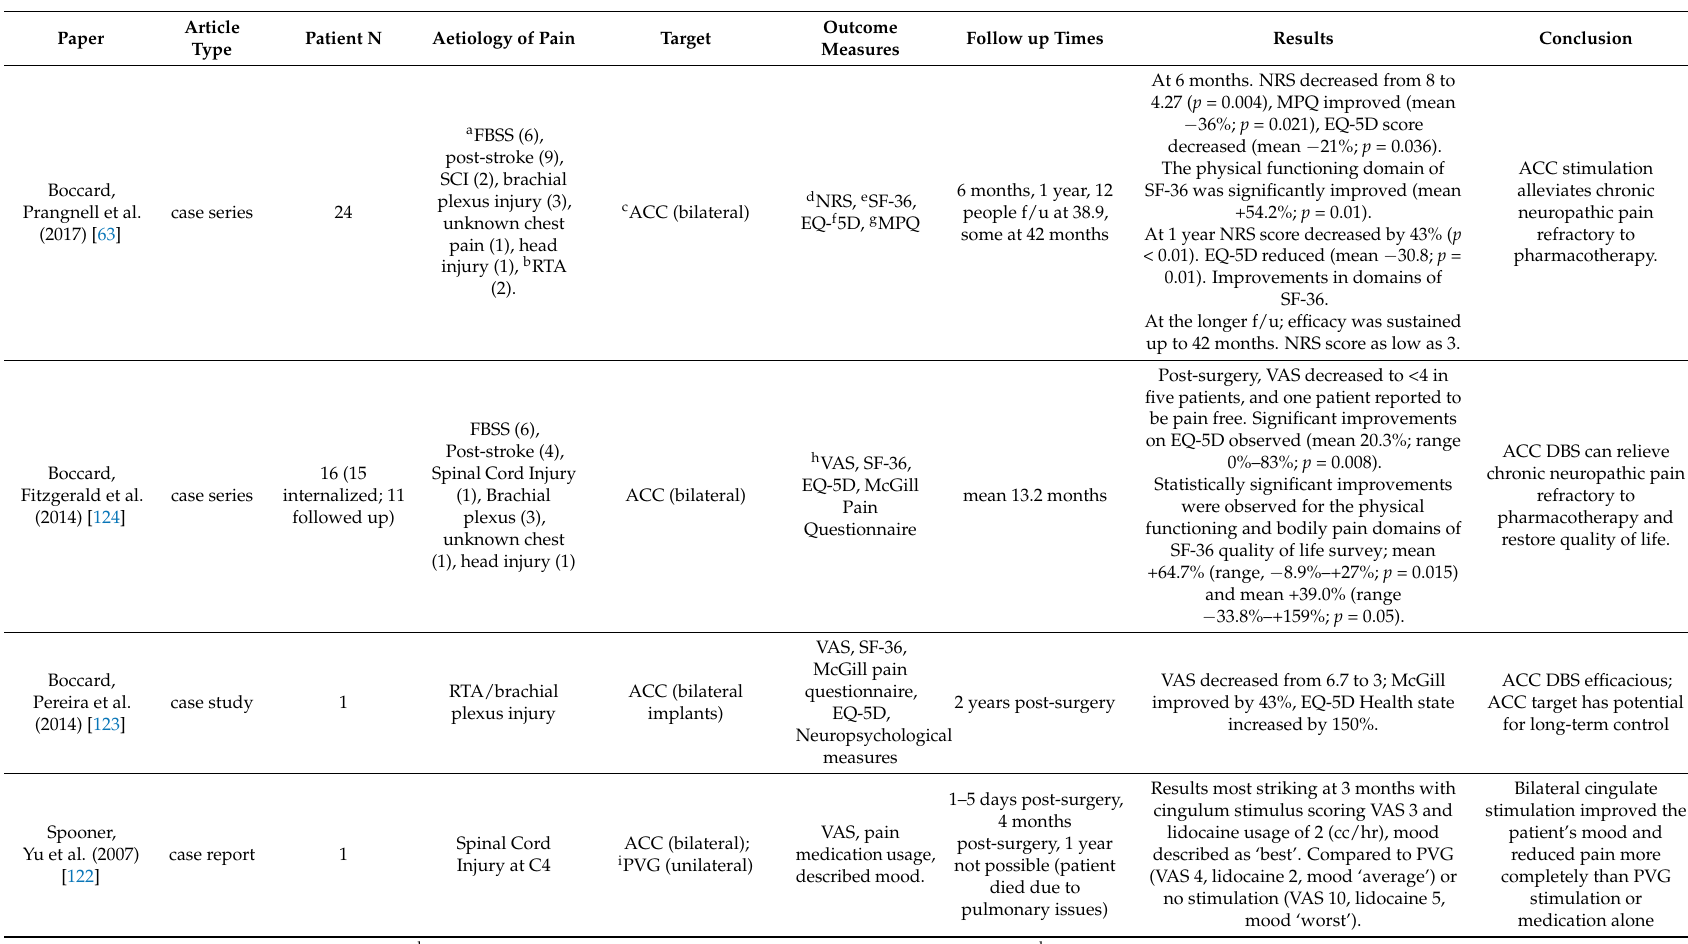
Table 1. Case studies and series of Deep Brain Stimulation targeting Anterior Cingulate